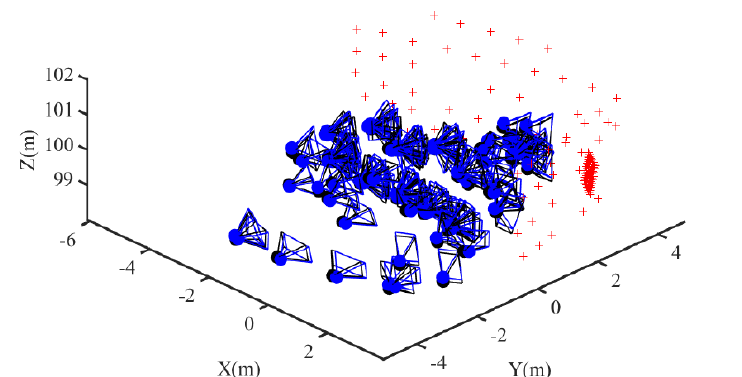
Figure 4. Calibration test field.